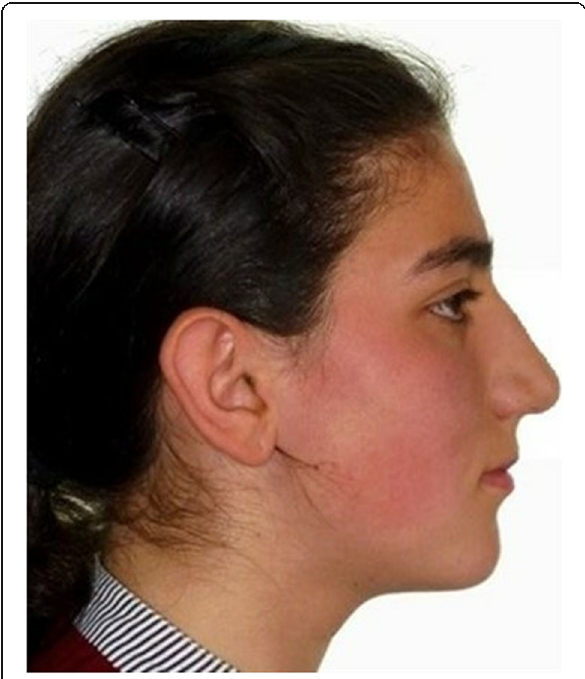
Fig. 3 Constructed photograph after virtual orthognathic surgery